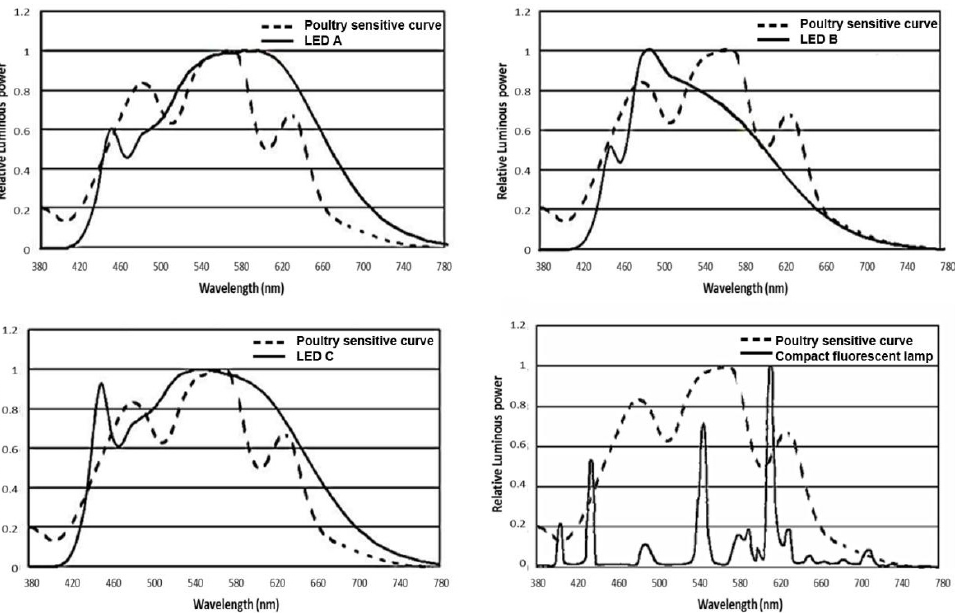
Table 1. Spectrum proportion characteristics of three light emitting diode bulbs and one compact fluorescent lamp.